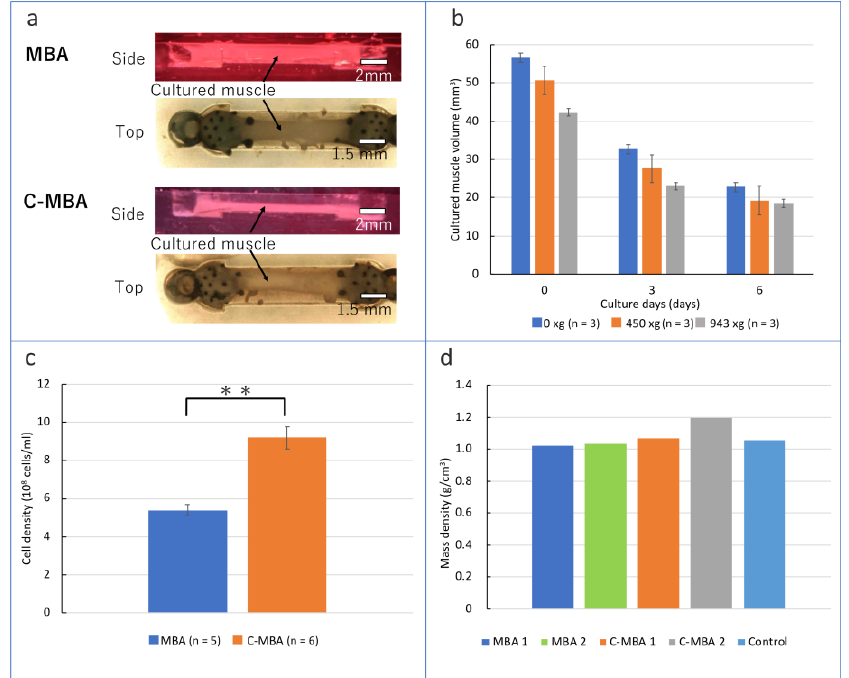
Figure 4. Effect on cultured muscle changed by centrifugal force: ( a ) side and top views of the fabricated MBA and C-MBA, ( b ) changes in volume of cultured muscle during culture, ( c ) cell density of cultured muscle changed by centrifugal force. Asterisks indicate comparable groups and statistical significance (** p < 0.01); ( d ) mass density of cultured muscle changed by centrifugal force.